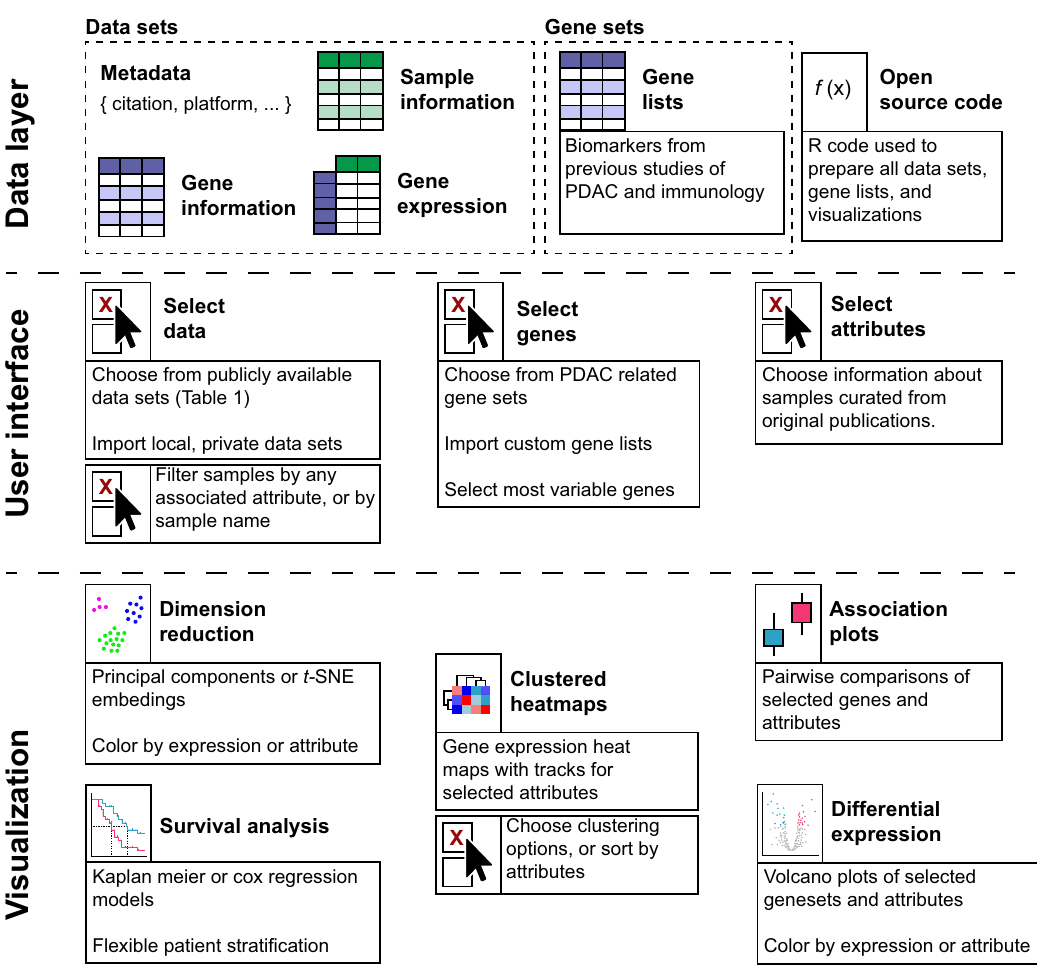
Fig. 1 Features and organization of the pdacR package. The pdacR package contains hand-curated and annotated datasets from many of the landmark PDAC studies conducted over the past decade and others. Data layer : Dataset sample- and gene-based data are organized by the primary author of the dataset and the year of publication. Gene lists de fi ned in these and other studies are compiled for ease of analysis, named by author and cell/tissue type de fi ned by the list (e.g., “ CIBERSORT Monocytes ” , a gene list that speci fi cally identi fi es cells of the monocyte lineage). User interface : A GUI that enables point-and-click is hosted online and also may be called locally by the user through the R Shiny interface. Users may select from the compiled datasets, fi lter samples, select genes to use in their analysis (either user-de fi ned or built into the package), and select factors from the samples with which to visualize the data. Visualization : The package includes functions to facilitate data analysis and visualization, either generated for this package or from others in the literature. In the GUI, users may save images from their analysis as PNGs or PDFs for further illustration and